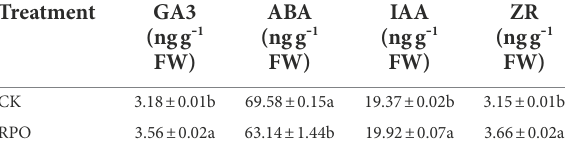
TABLE 3 Effect of RPO film on endogenous hormones in sweet pepper fruits. Treatment